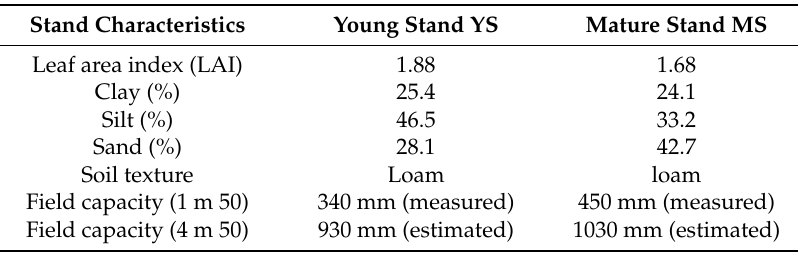
Table A2. List of variables characterizing the soil and forest canopy, measured on the young (YS) and mature stands (MS) of the Bellif